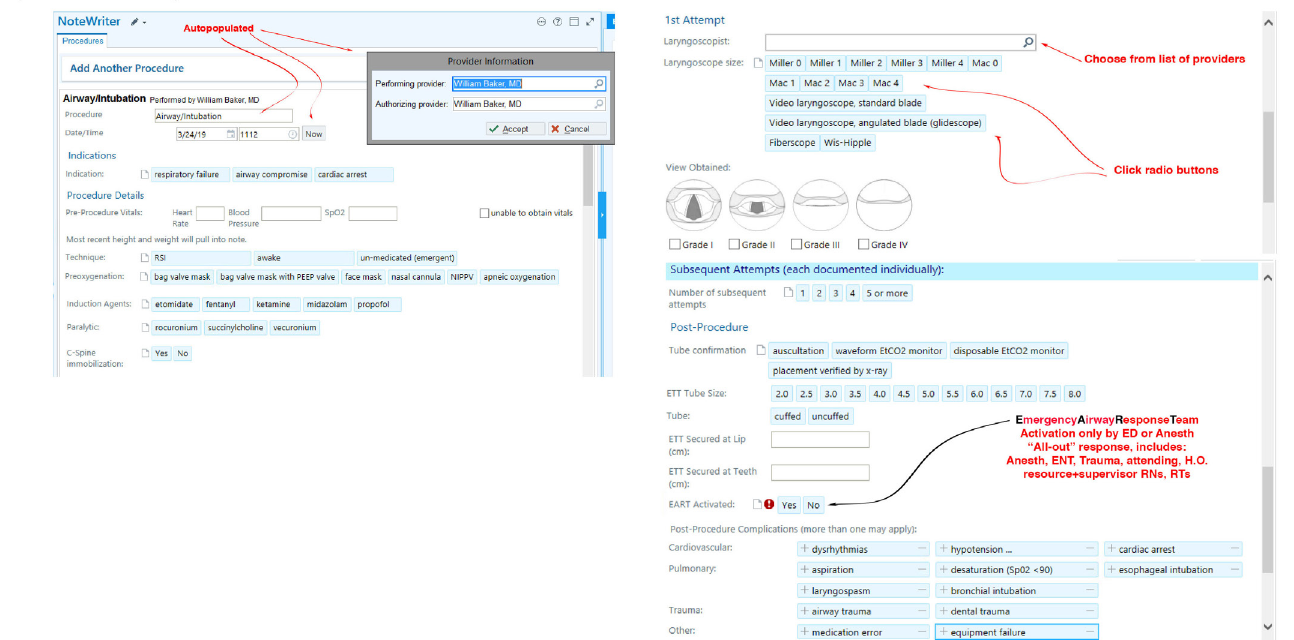
Figure 1. Screenshots of electronic health record airway procedure note that is created for each endotracheal intubation. The patient name, time and author are auto-populated fields. The clinician is prompted to document each attempt individually and select multiple post-procedure